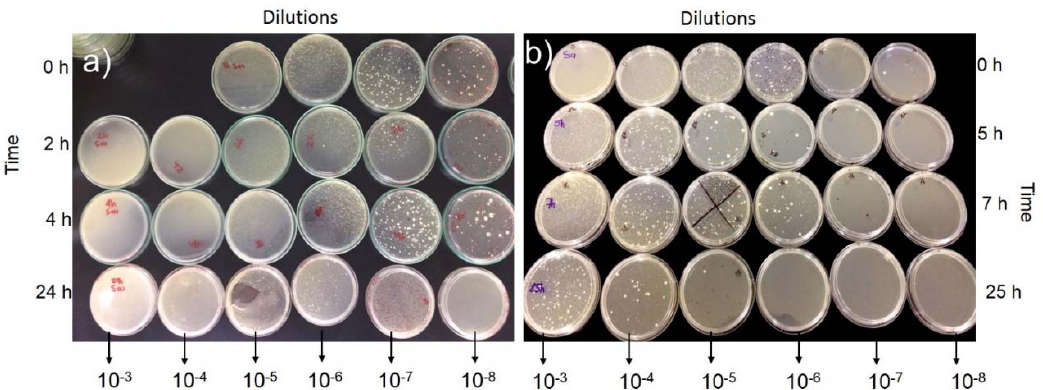
Figure 9. Reduction in the number of viable bacteria over time in the S. aureus agar for ( a ) GP and ( b ) GP ‐ G. Table 6. Bacterial growth inhibition capacity of GP (24 h) and GP ‐ G (25 h) in bacteria ‐ rich agar solutions.